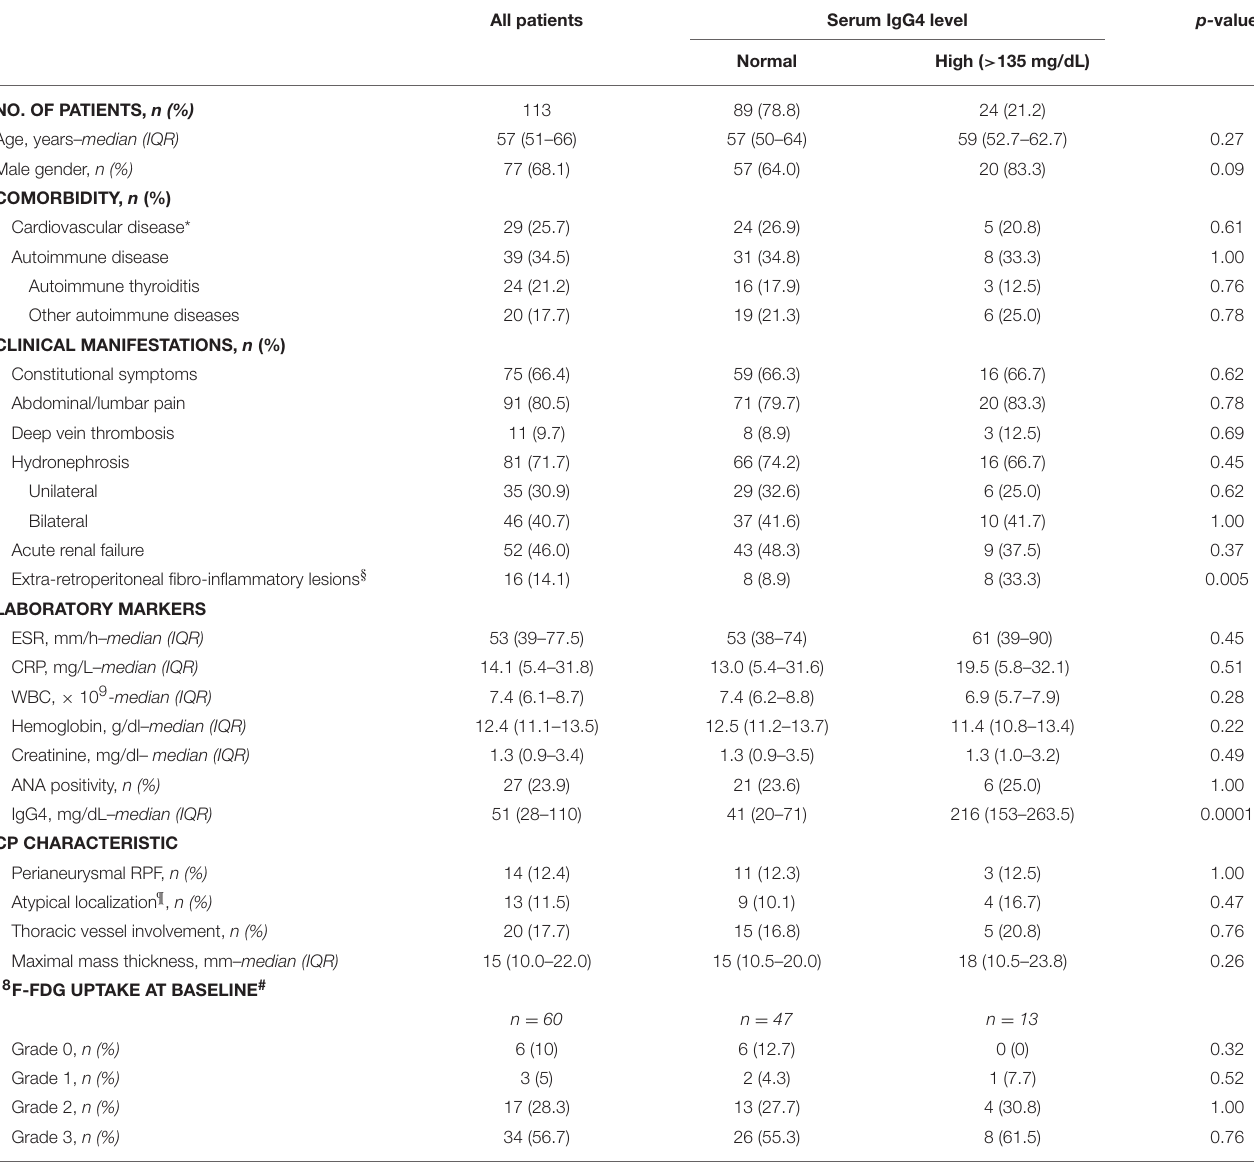
TABLE 1 | Main characteristics of the 113 patients at the time of inclusion in the study. All patients Serum IgG4 level p-